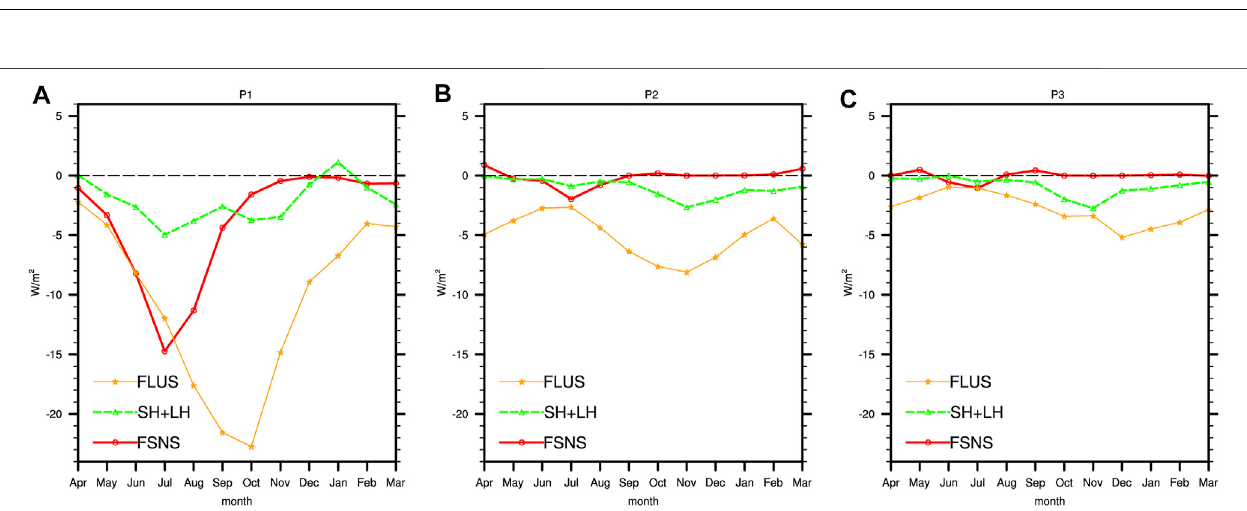
FIGURE 7 | Annual cycle of the sea ice concentration (SIC, %) anomalies (red lines) and sea ice extent (SIE, 10 6 km 2 ) anomalies (blue lines) over the Arctic during Period-1 (A) , Period-2 (B) , and Period-3 (C) after the Samalas mega volcanic eruption.